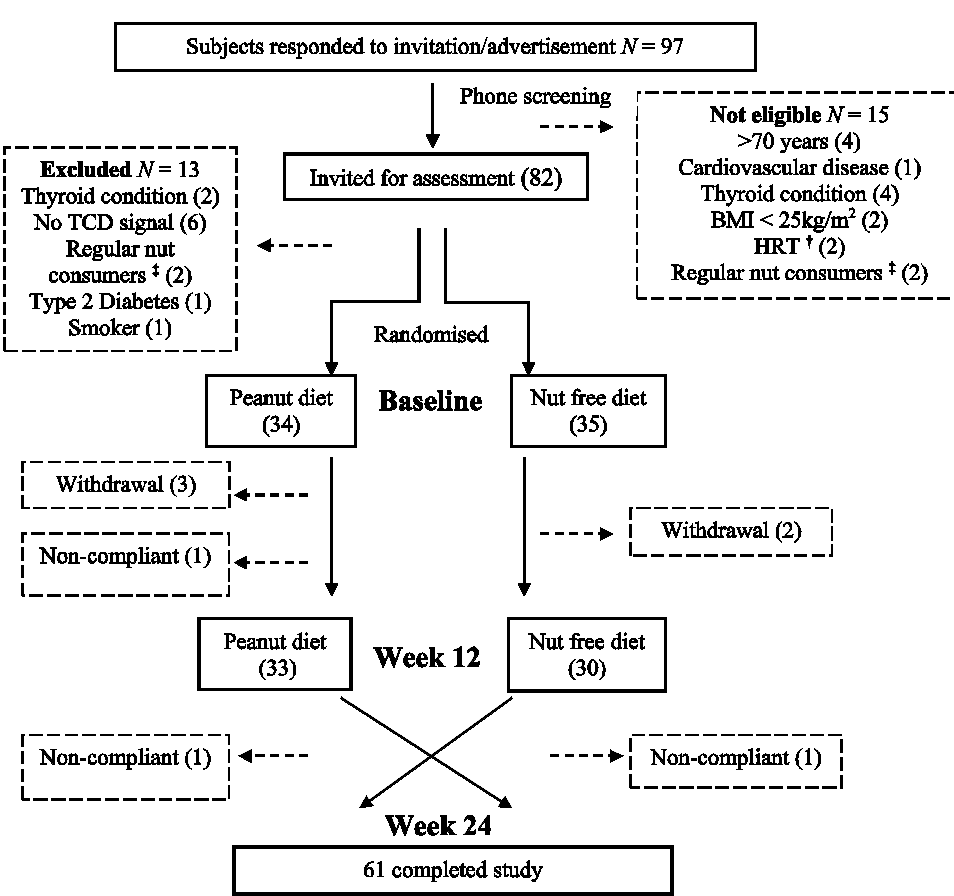
Figure 1. Consort diagram of subjects who were screened, enrolled and completed the study. † Hormone replacement therapy; ‡ consuming ≥30 g nuts/week.